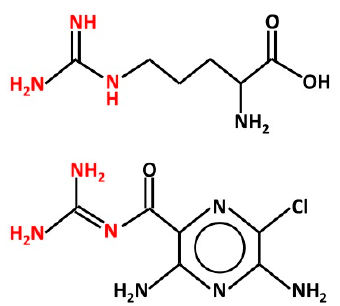
Figure 1. Structure of L-arginine (top) and amiloride (bottom). Both chemicals bear a guanidinium group (red), which is protonated in physiological conditions. This group is believed to interact with the ENaC channel pore from the extracellular space.